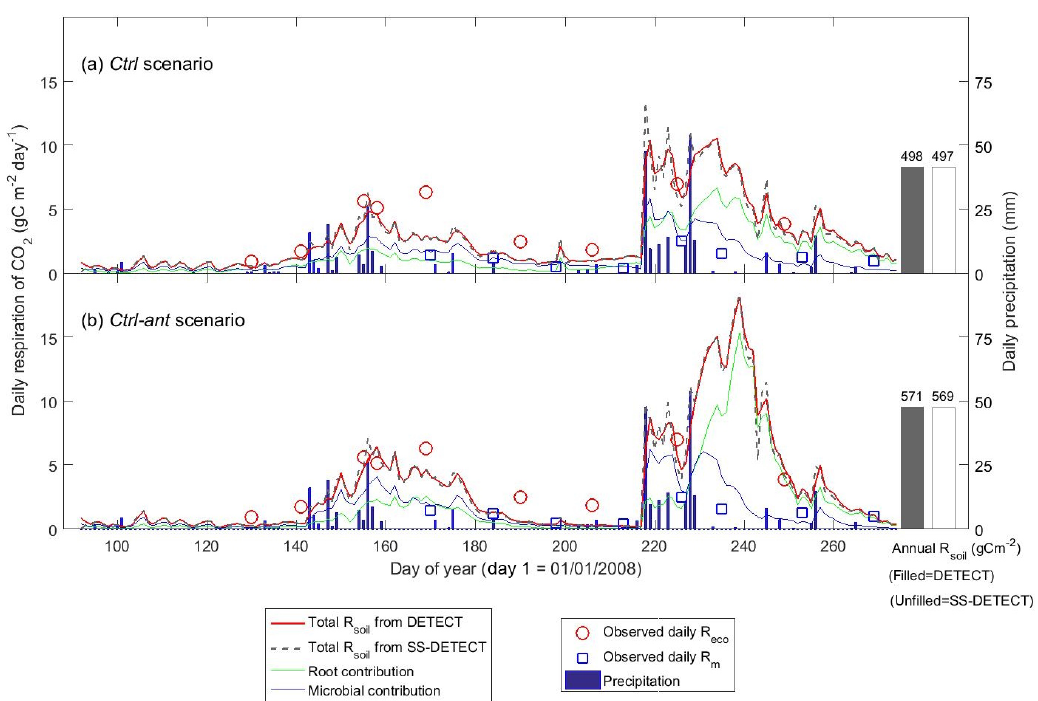
Figure 2. Time series of daily surface soil CO 2 fluxes ( R soil ) predicted by the non-steady-state (DETECT) and steady-state (SS-DETECT) models over the growing season (1 April–30 September), based on the control scenarios (a) without (Ctrl) and (b) with (Ctrl-ant) antecedent effects (see Table 2). Only R soil is simulated using the SS-DETECT model, whereas R soil and its root and microbial contributions are simulated using the DETECT model. The predicted fluxes are overlaid with observed ecosystem respiration ( R eco ; R soil + aboveground plant respiration) and microbial respiration ( R m ; based on plots where vegetation was